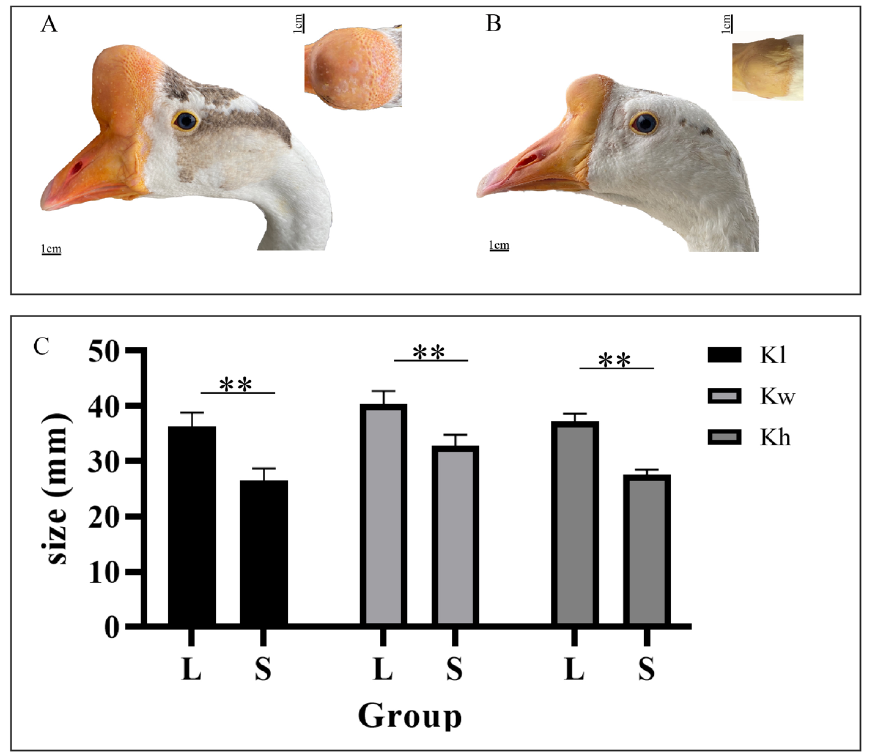
Figure 2. Phenotypes of knobs with different sizes in Yangzhou geese. ( A , B ) Differences in knob sizes were observed at 380 days of age between geese with large (L) knobs ( A ) and geese with small (S) knobs ( B ). ( C ) Comparison of knob sizes in the L and S groups. Significant differences are indicated with two asterisks ( P < 0.01). Kl knob length, Kw knob width, Kh knob